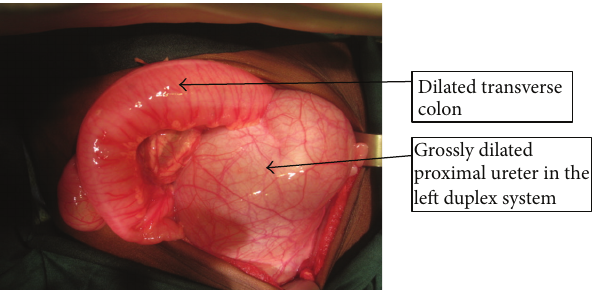
Figure 4: Intraoperative picture showing grossly dilated left prox- imal ureter in the duplex system (compared with the size of the dilated transverse colon in the